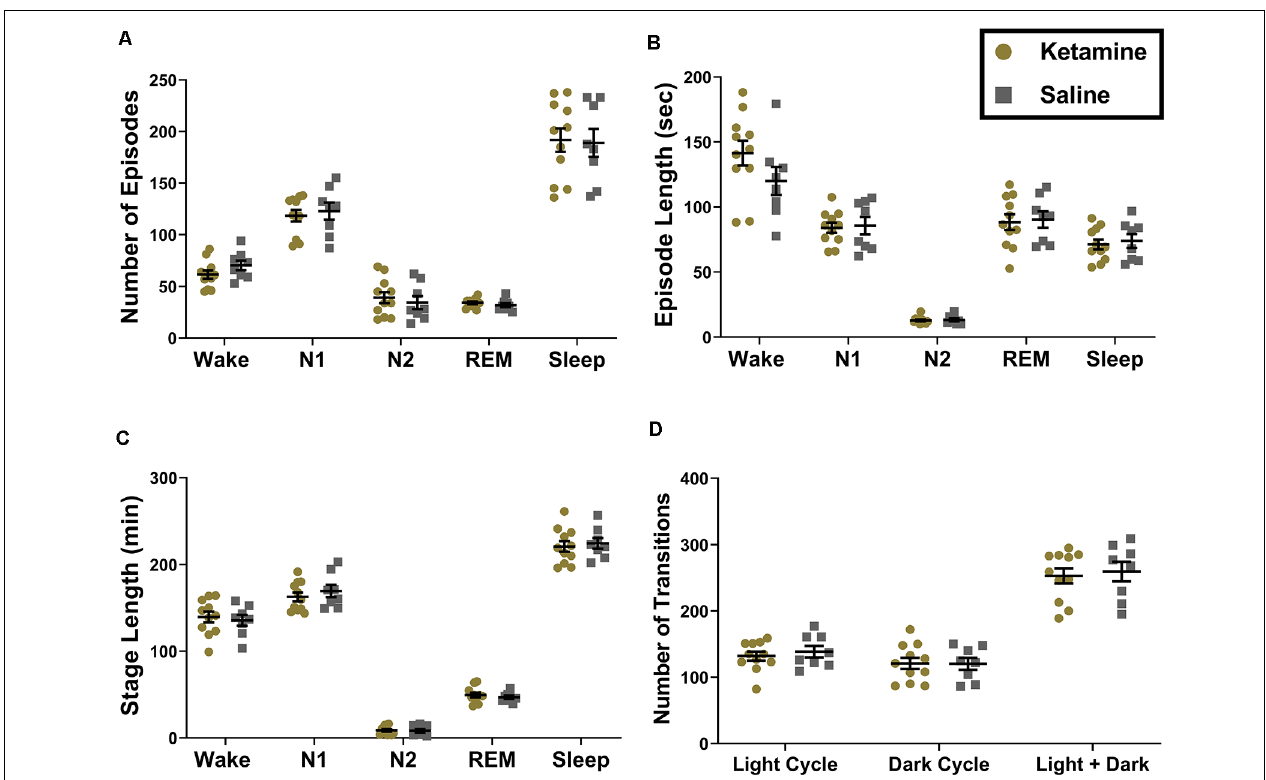
FIGURE 2 | Ketamine exposure during the neonatal period does not result in changes in sleep macrostructure measured across light and dark cycles combined. (A) We did not note any changes in the number of episodes in the Wake ( P = 0.165), N1 ( P = 0.663), N2 ( P = 0.581), REM ( P = 0.322) and total Sleep stages ( P = 0.880). (B) Moreover, the average length of each episode did not differ between groups for Wake ( P = 0.154), N1 ( P = 0.823), N2 ( P = 0.772), REM ( P = 0.824), and total Sleep ( P = 0.687). (C) The total amount of time spent in each sleep stage also did not change as a result neonatal ketamine exposure across Wake ( P = 0.685), N1 ( P = 0.439), N2 ( P = 0.836), REM ( P = 0.824), or total Sleep ( P = 0.691). (D) Finally, we measured how often rats transitioned from one sleep stage to another and found no changes in this parameter across the light cycle ( P = 0.533), dark cycle ( P = 0.969), and when cycles were combined ( P = 0.733) in response to neonatal ketamine